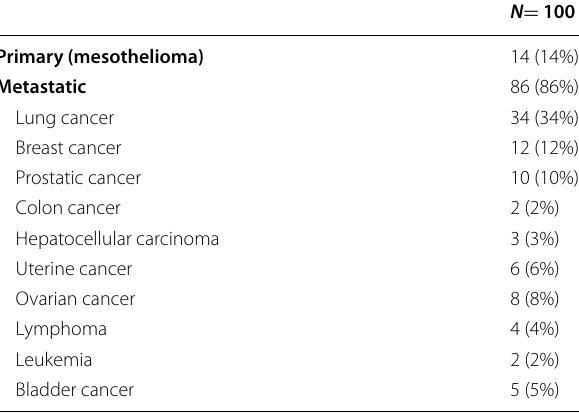
Table 2 Type of malignancy among the studied patients